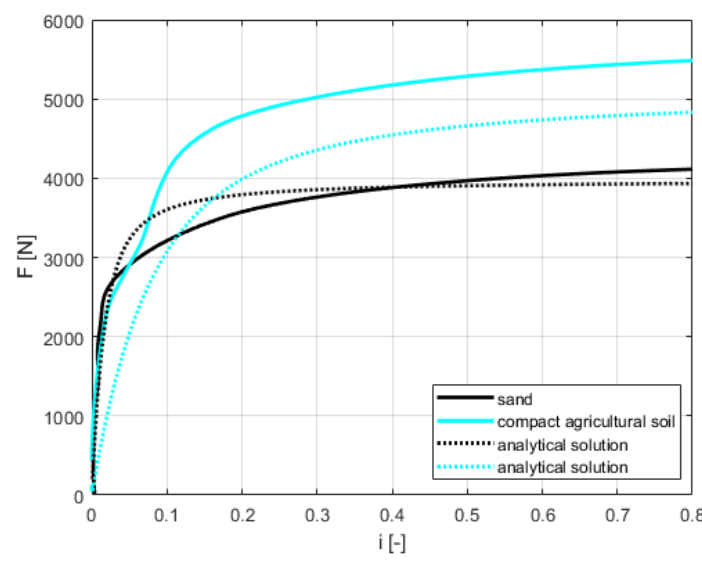
Figure 17. Traction force-slip curves.